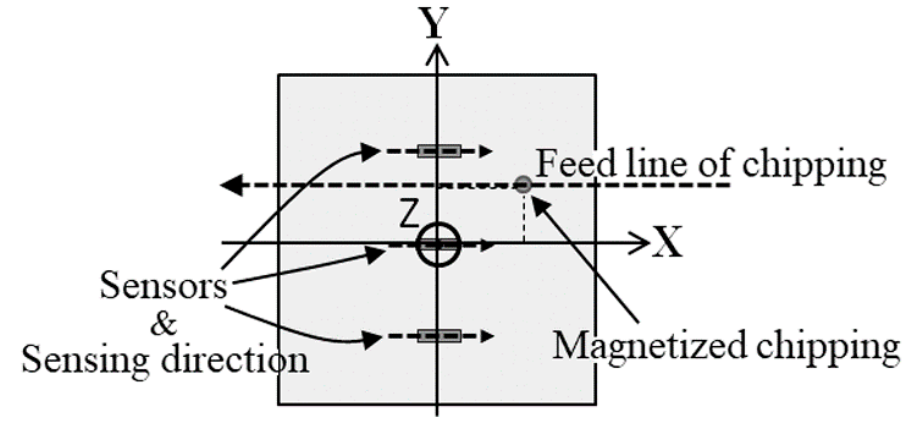
Figure 5. Top view of the structure of the position estimation system. Based on the above Equation, sensing waveforms were numerically estimated as shown in Figure 6. This indicated feeding dipole waveforms that were detected by three sensors placed in different positions. Each waveform had one minimum point and one maximum point, and the zero-crossing point between them indicated that the dipole was placed just above the measuring sensor element.